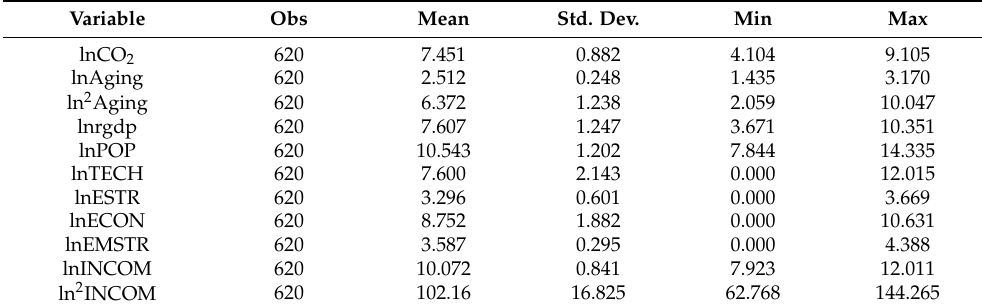
Table 2. Descriptive statistical analysis.